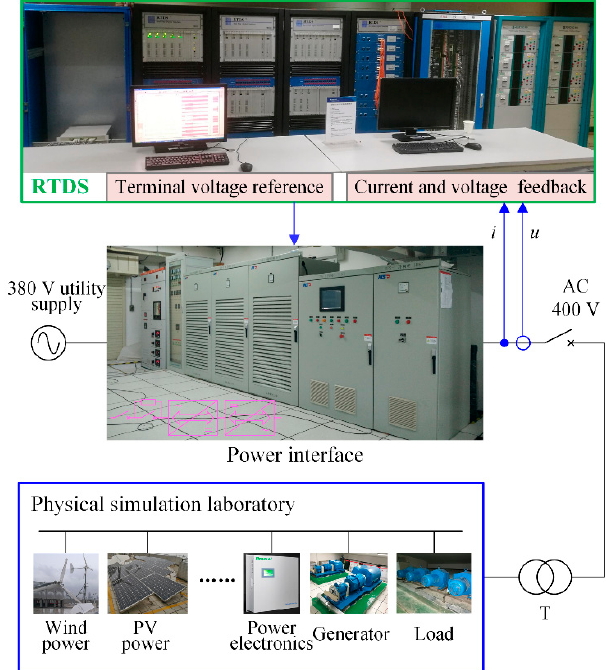
Figure 1. Facility layout of the digital-physical hybrid real-time simulation platform.